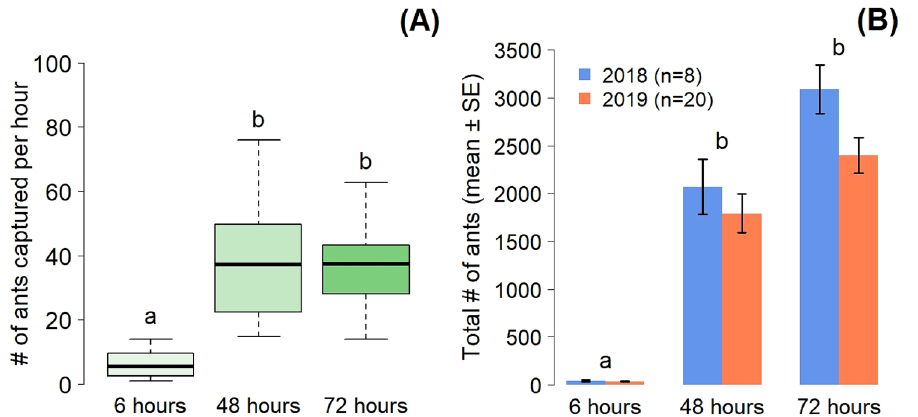
Figure 1. ( A ) Ant activity as ants captured per hour since carrion placement is obtained by the mean number of fire ants (from both 2018 and 2019) around each carcass was divided by the number of hours since rat carrion placement. ( B ) Mean number of ants per pair of pitfall traps placed adjacent to the rat carcass for the samples collected in 2018 (blue) and 2019 (red). Letters above bars represent the results of the post-hoc pairwise comparison analysis. Bars sharing a letter are not significantly different (P <